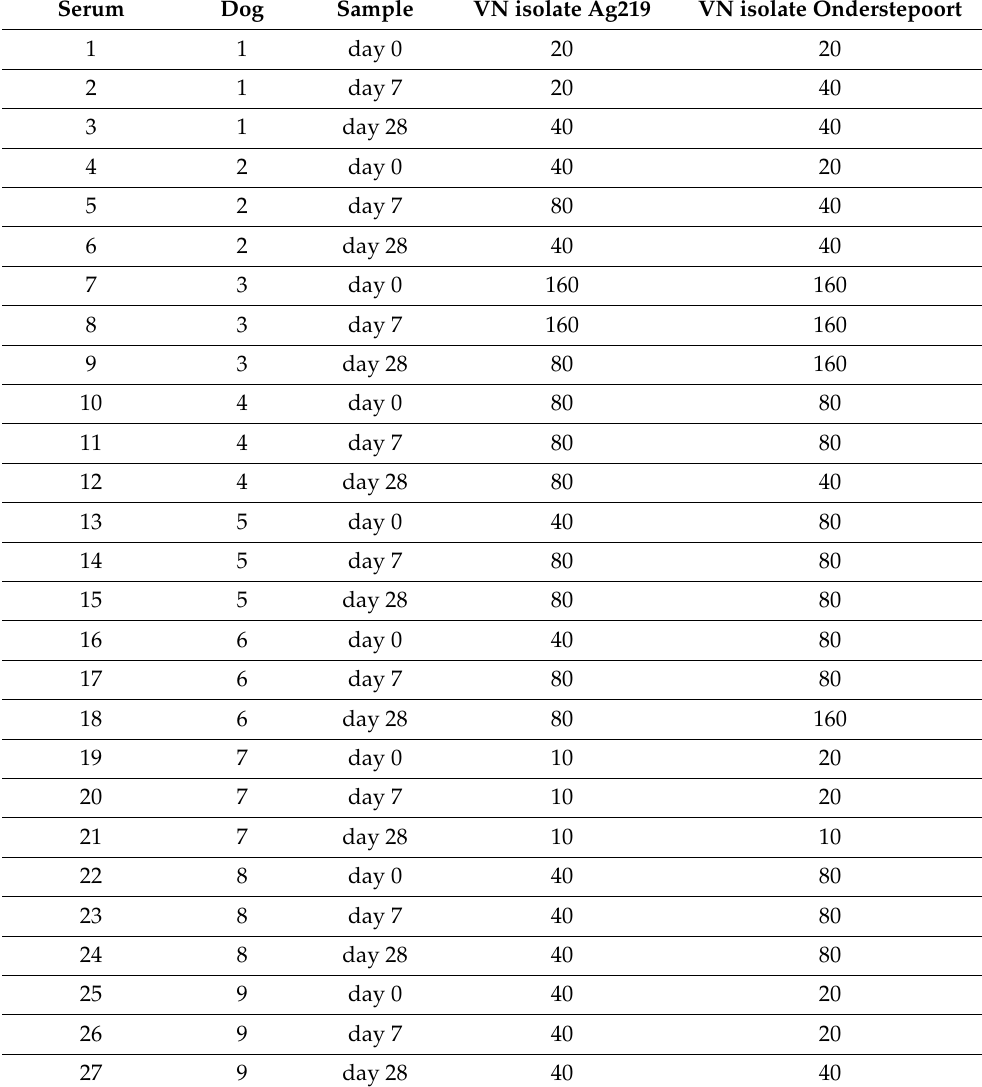
Table 3. Comparison of the results of virus neutralization (VN) using isolate Ag219 and Onderstepoort. Serum Dog Sample VN isolate Ag219 VN isolate